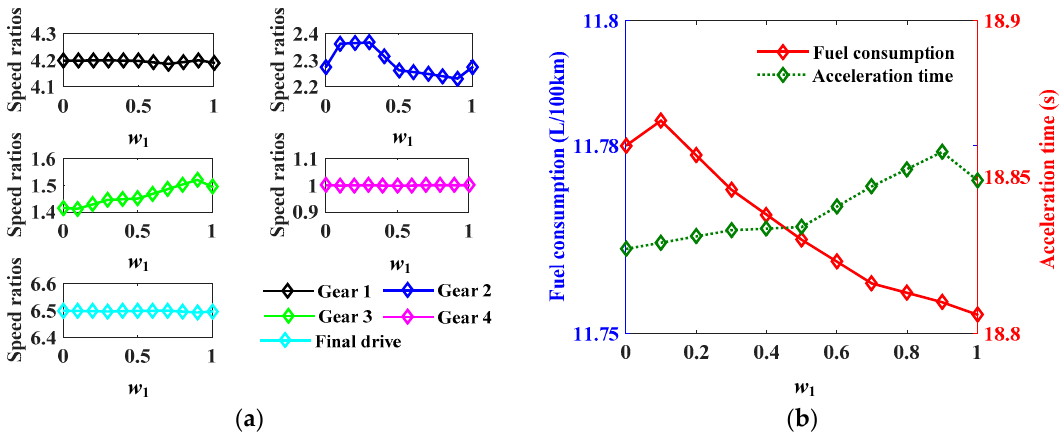
Figure 13. The optimal speed ratios.